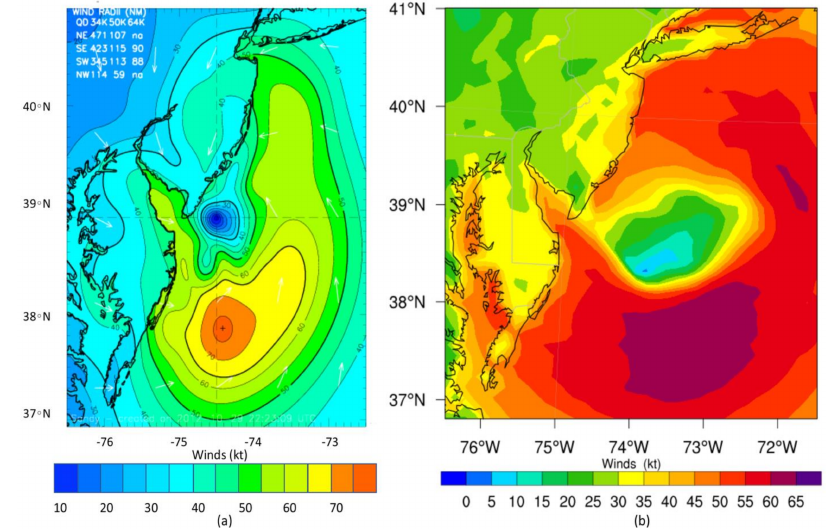
Figure 6. Wind field analysis for 2100 UTC 29 October 2012 from ( a ) HWIND (source: NOAA/AOML/Hurricane Research Division); ( b ) WRF 12-4 km